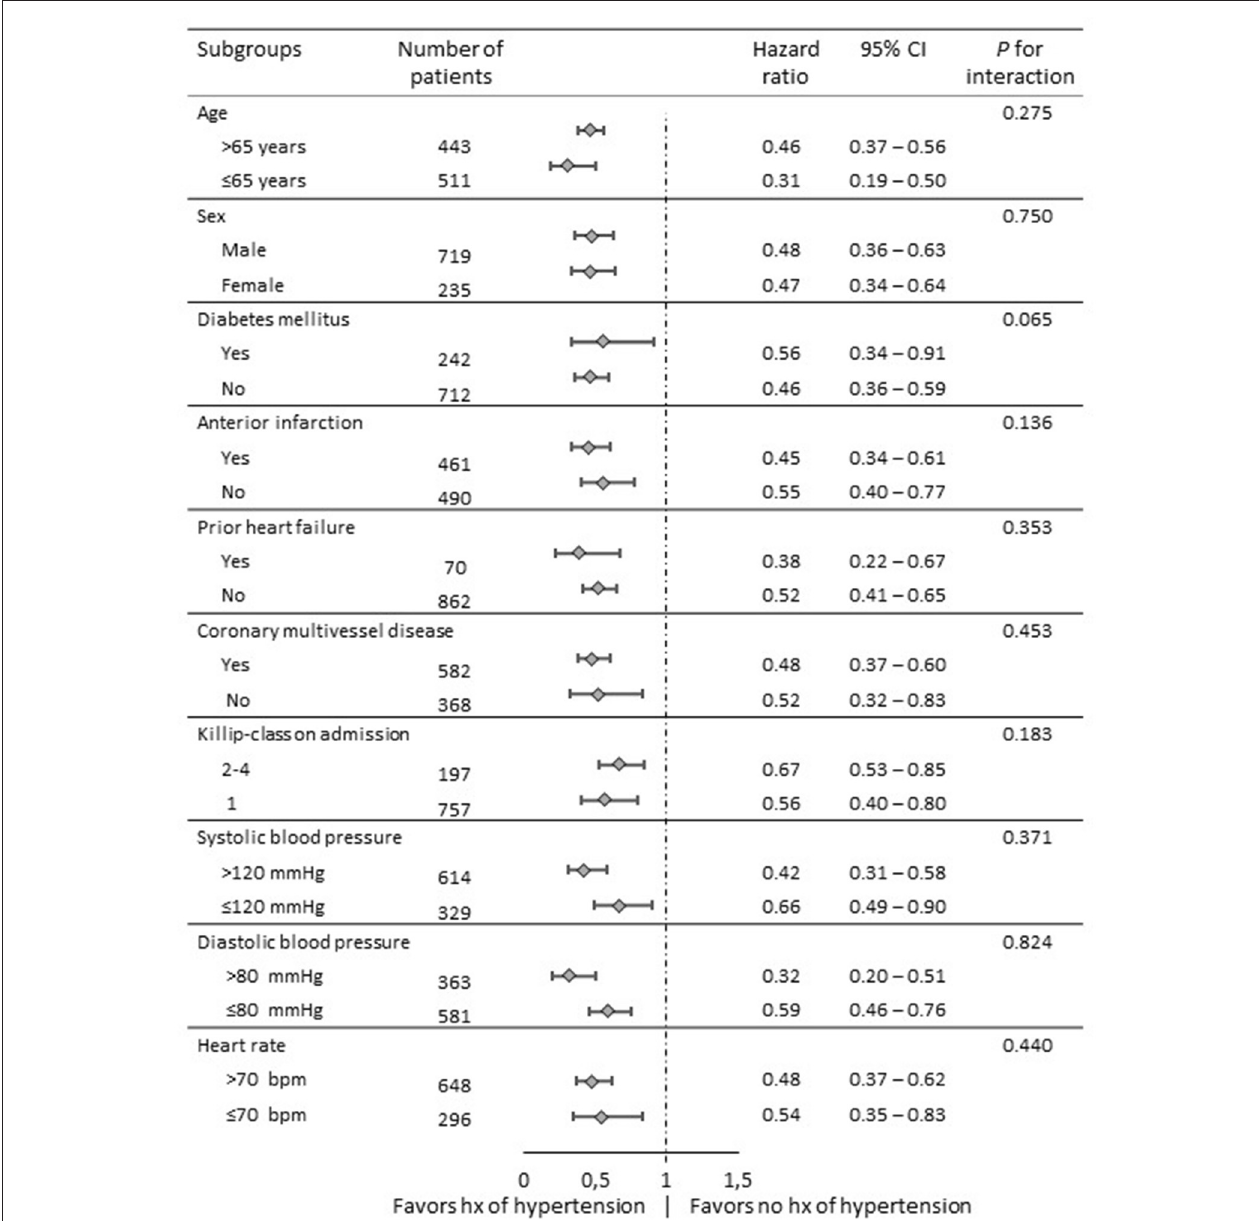
FIGURE 3 | Comparative hazard ratios of all-cause mortality for subgroups in overall populations. Level of significance: p < 0.05. CI: confidence interval.